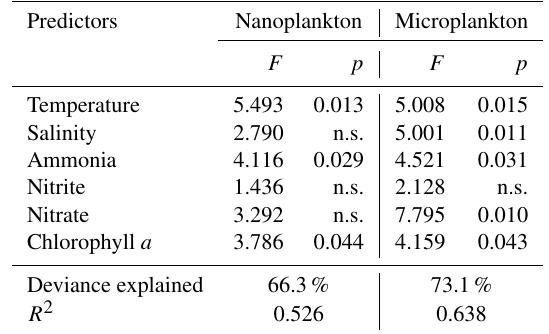
Table 2. Coefficients ( F) and significance levels ( p) of the effects of variable predictors on δ 15 N of nanoplankton (plankton < 20µm) and microplankton (plankton > 20µm) using a generalized additive model test. P value < 0.05 indicates significance. The abbreviation “n.s.” stands for “no significance”.